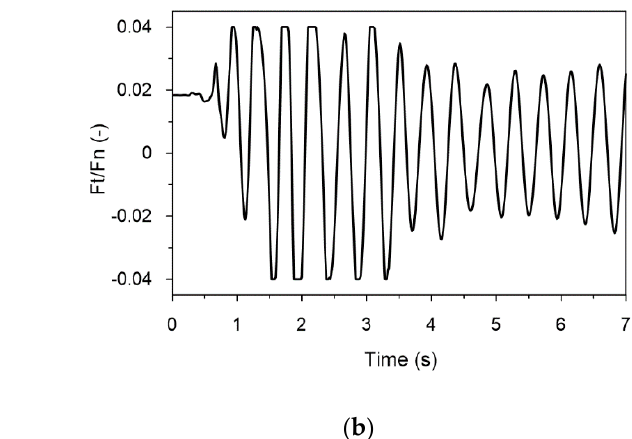
Figure 21. Comparison of: ( a ) the forces generated in the connector (models M1 and M2); ( b ) the friction force to the normal contact force ratio (model M2), obtained for the tremor of medium intensity (D_II).